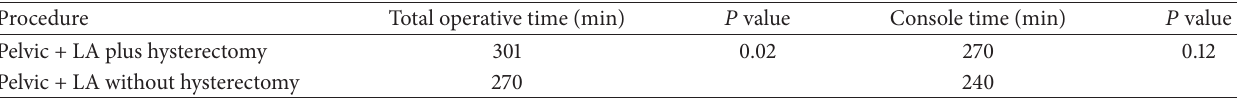
Table 2: Operation and console time.